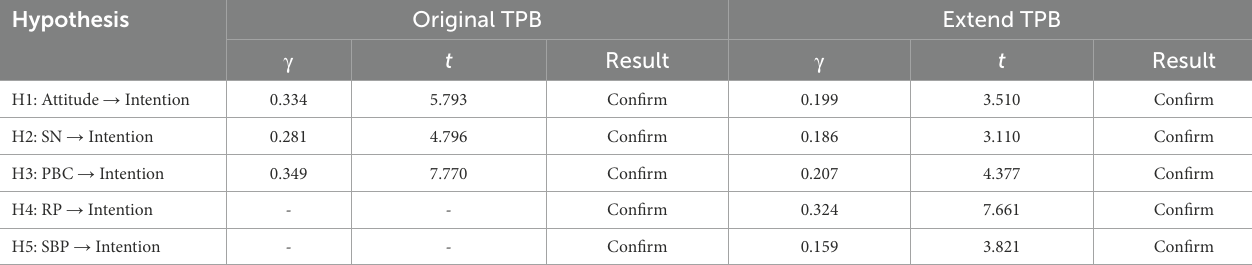
TABLE 6 Results of the research structural